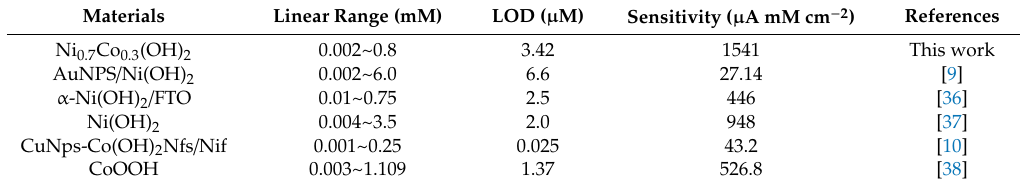
Figure 6. ( a ) Current responses of Ni 0.7 Co 0.3 (OH) 2 / CP at + 0.5, + 0.6, and + 0.7 V vs. Hg / HgO with the changing concentration of glucose. ( b ) The calibration plot of glucose concentration to the current density of ( a ); the illustration shows the linear section. ( c ) The sensitivities of di ff erent electrodes obtained by the slope of the linear part of di ff erent samples at + 0.5, + 0.6, and + 0.7 V vs. Hg / HgO. Table 1. Summary of sensing performances of nickel, cobalt, and nanostructure-based electrodes.